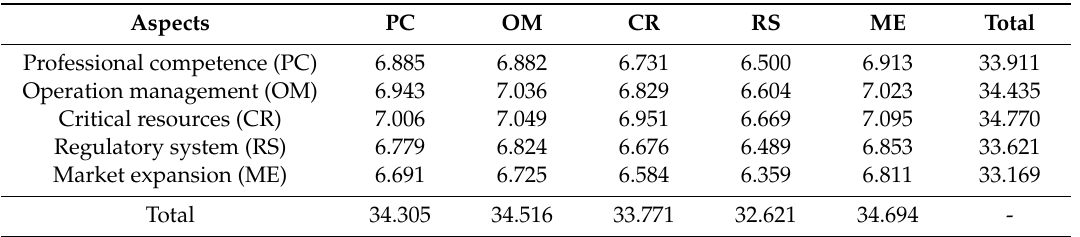
Table 7. The indirect influence matrix